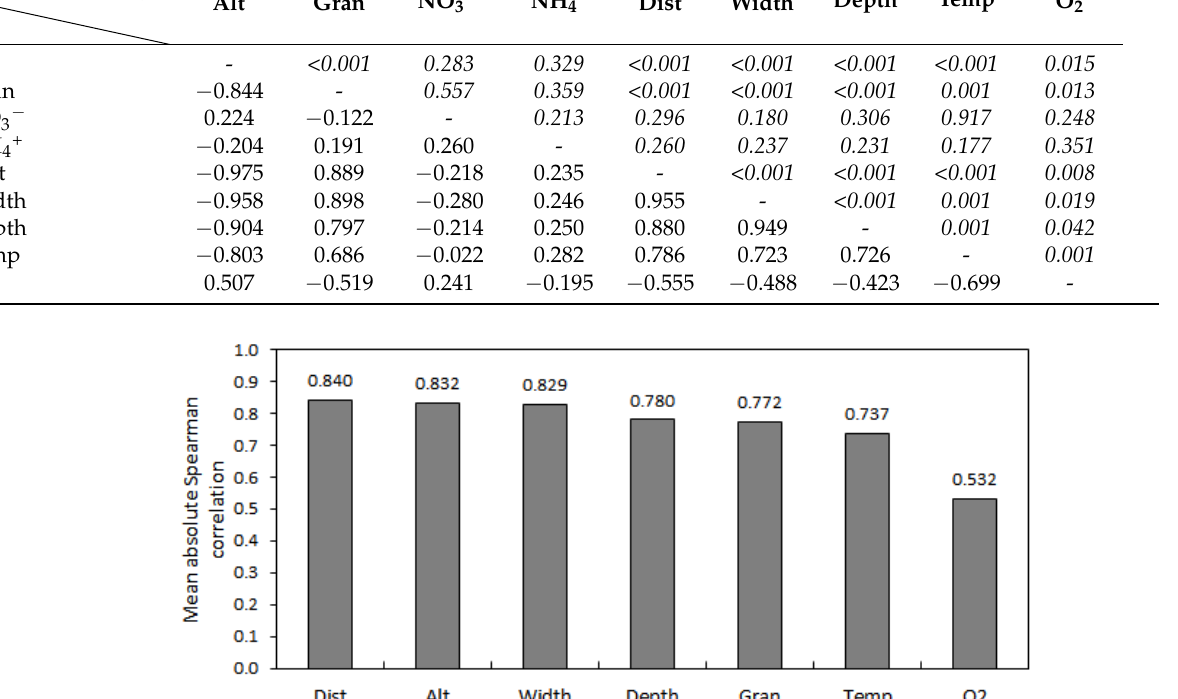
Table 3. Spearman (r) correlations among environmental variables (low half) and their p -values in italics (upper half).